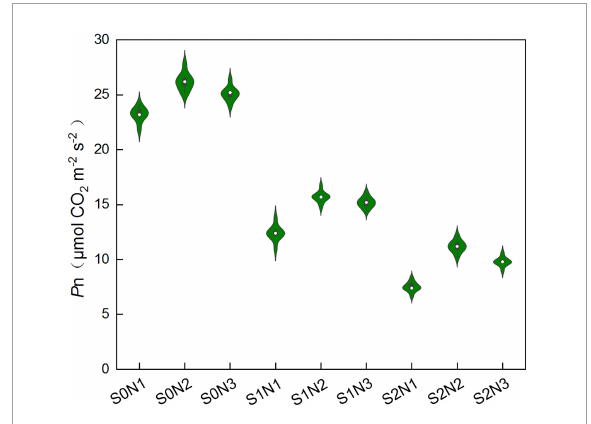
FIGURE5 Effects of different salt concentrations and nitrogen rates on leaf net photosynthesis rate ( P n) of rice at heading stage. S 0 , S 1 , and S 2 denote salt concentrations of 0, 1.5, and 3.0 g kg − 1 NaCl, respectively; N1, N2, and N3 denote nitrogen rates of 210, 300, and 390 kg ha − 1 . The data ( n = 9) are mean values ± SD, calculated from nine independent